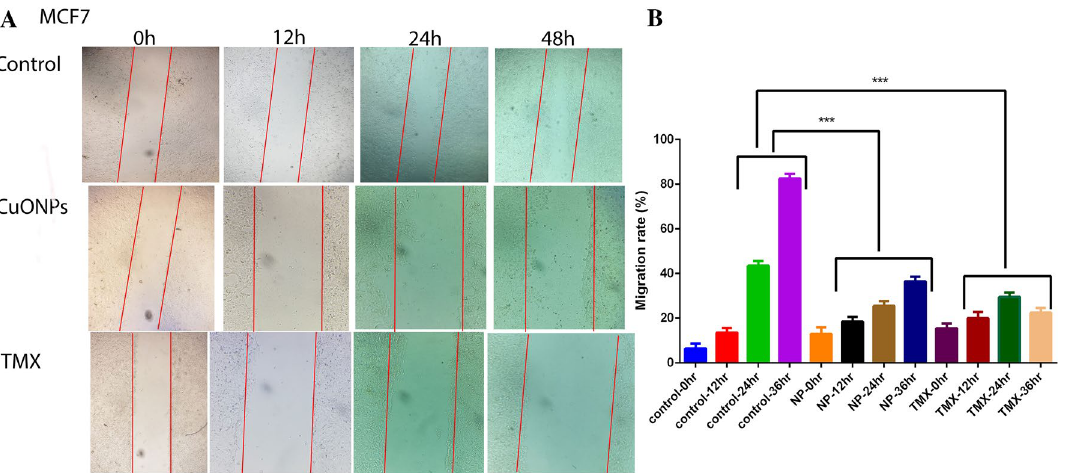
Figure 13. ( A ) Scratch assay in MCF7 cell lines treated with IC 50 concentrations of BC-CuONPs and tamoxifen (TMX) after 48 h. ( B ) Comparison of scratch tests in controls and MCF7 cells treated with IC 50 concentrations of BC-CuONPs and tamoxifen in 12, 24, and 36 h treatments. ***: P <